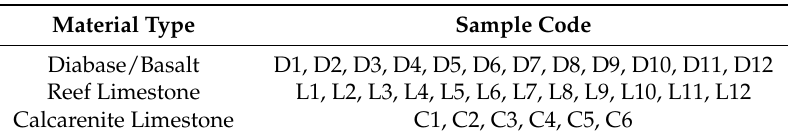
Figure 1. Map of Cyprus showing the four geomorphological regions of the island and sampling locations. Table 1. List of test samples.